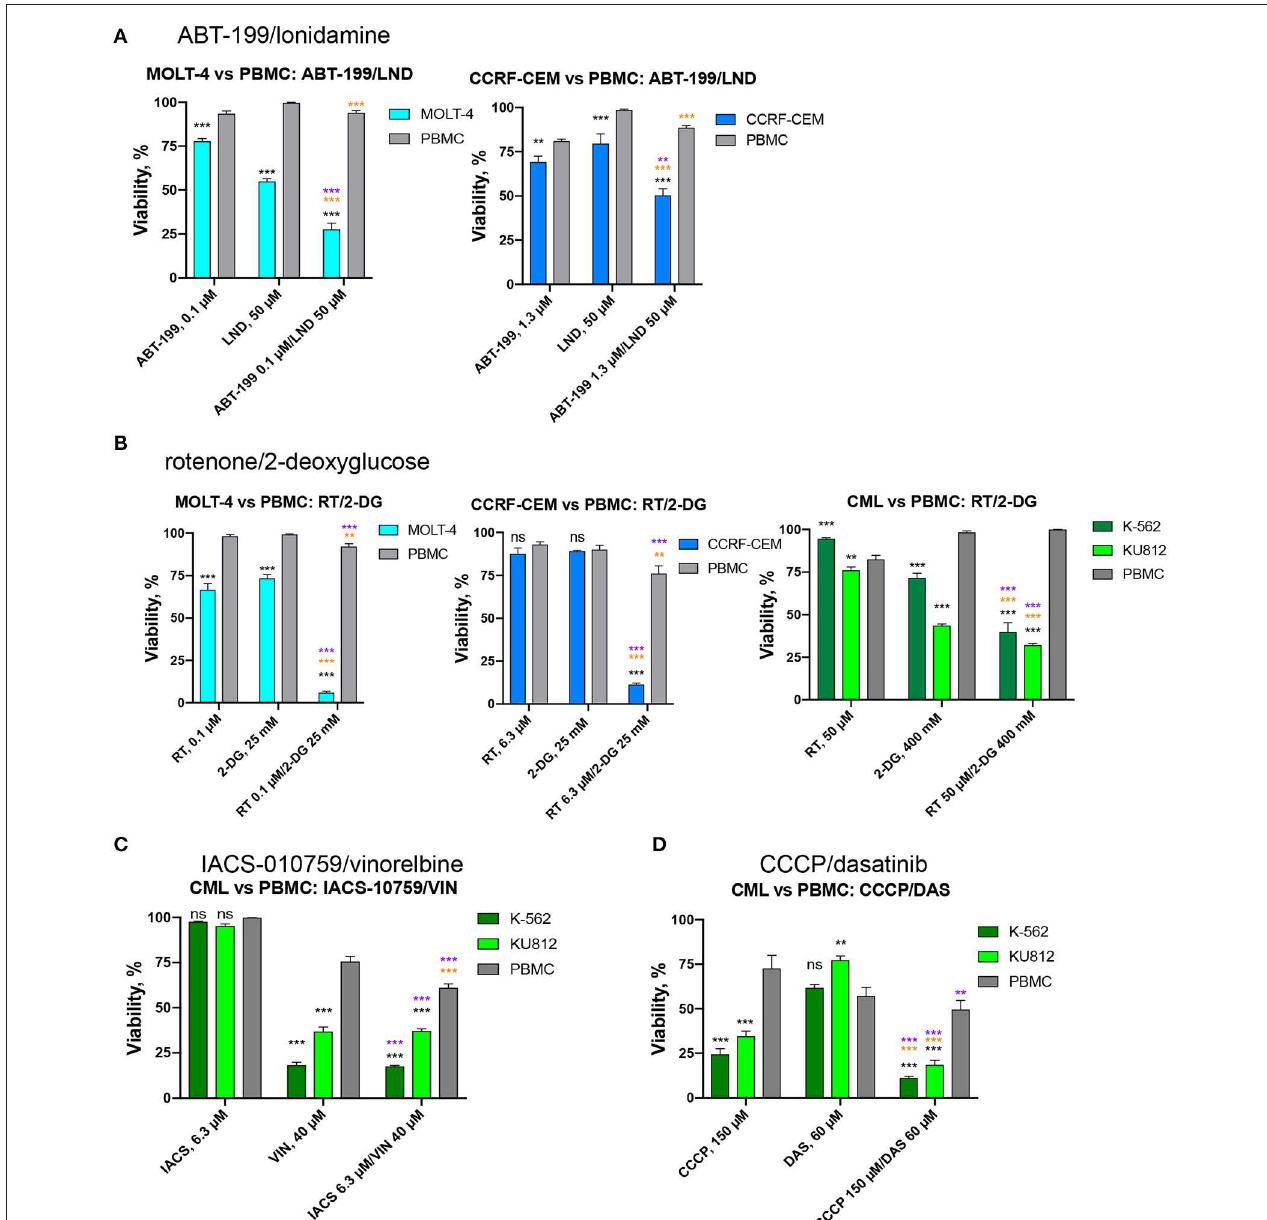
FIGURE 9 | Effect of selected drug combinations and corresponding single drugs on ALL/CML cell lines or healthy PBMCs. Survival of CCRF-CEM or MOLT-4 cells (ALL), K-562 and KU812 cells (CML), or healthy PBMCs following single and combinatorial treatments at the dose of maximum selectivity. (A) ABT-199/lonidamine against ALL cells vs. PBMCs; (B) rotenone/2-deoxy-D-glucose against ALL/CML cells vs. PBMCs. (C,D) IACS-010759/vinorelbine or CCCP/dasatinib against CML cells vs. PBMCs. Shown are mean ± SEM from at least three independent biological replicates. Significance of changes in survival was assessed via Student’s t -test. *** p < 0.001; ** p < 0.01; ns: p > 0.05. Black stars or ns indicate comparison of ALL/CML cells vs. healthy PBMCs under the same treatment condition; purple stars indicate significantly lower survival under combinatorial treatment compared to single mitocan for each cell line; orange stars indicate significantly lower survival under combinatorial treatment compared to single complementary drug for each cell line.